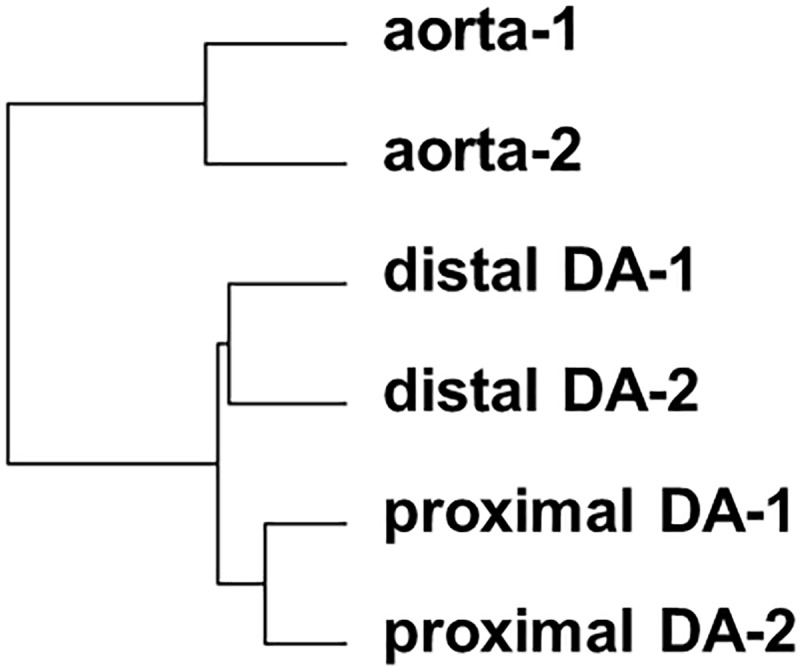
Hierarchical clustering of normalized DNA array data.The graphical representation showed that the profiles of gene expression were grouped into two distinct clusters: a DA-related cluster and an aorta-related cluster (distance = 1 − Pearson’s correlation coefficient, Ward’s method).